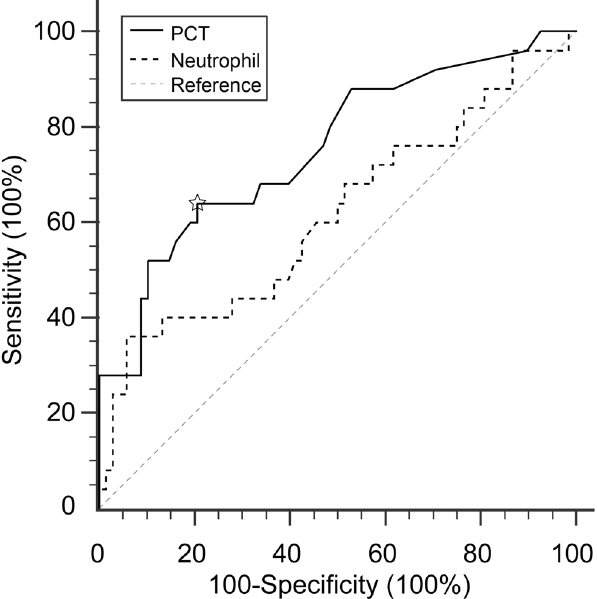
Figure 3. The ROC curves of serum PCT levels and neutrophil counts. The reference line is denoted as the dotted diagonal. ☆ The optimal cutoff value of PCT